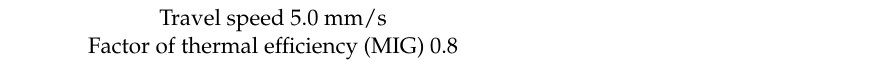
Figure 2. Grooved sheets of different steels’ grades prepared for welding; inlet after welding. Table 3. The main parameters of welding procedure.